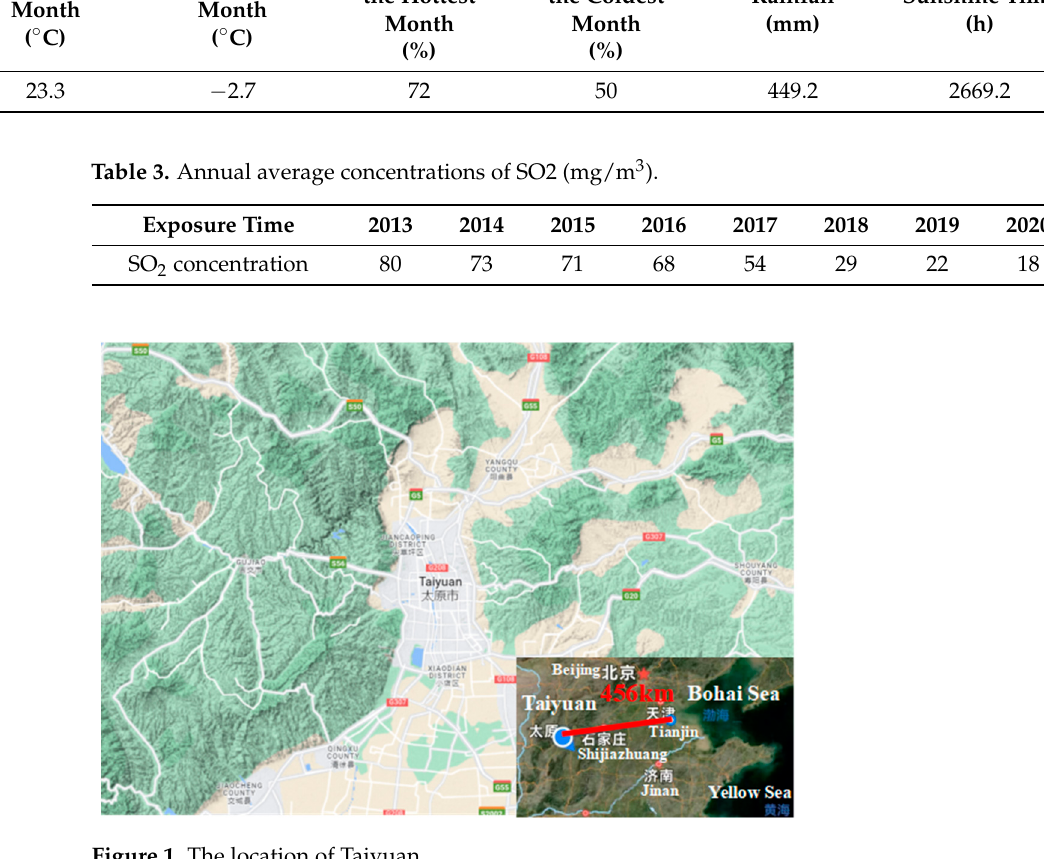
Table 3. Annual average concentrations of SO2 (mg/m 3 ).